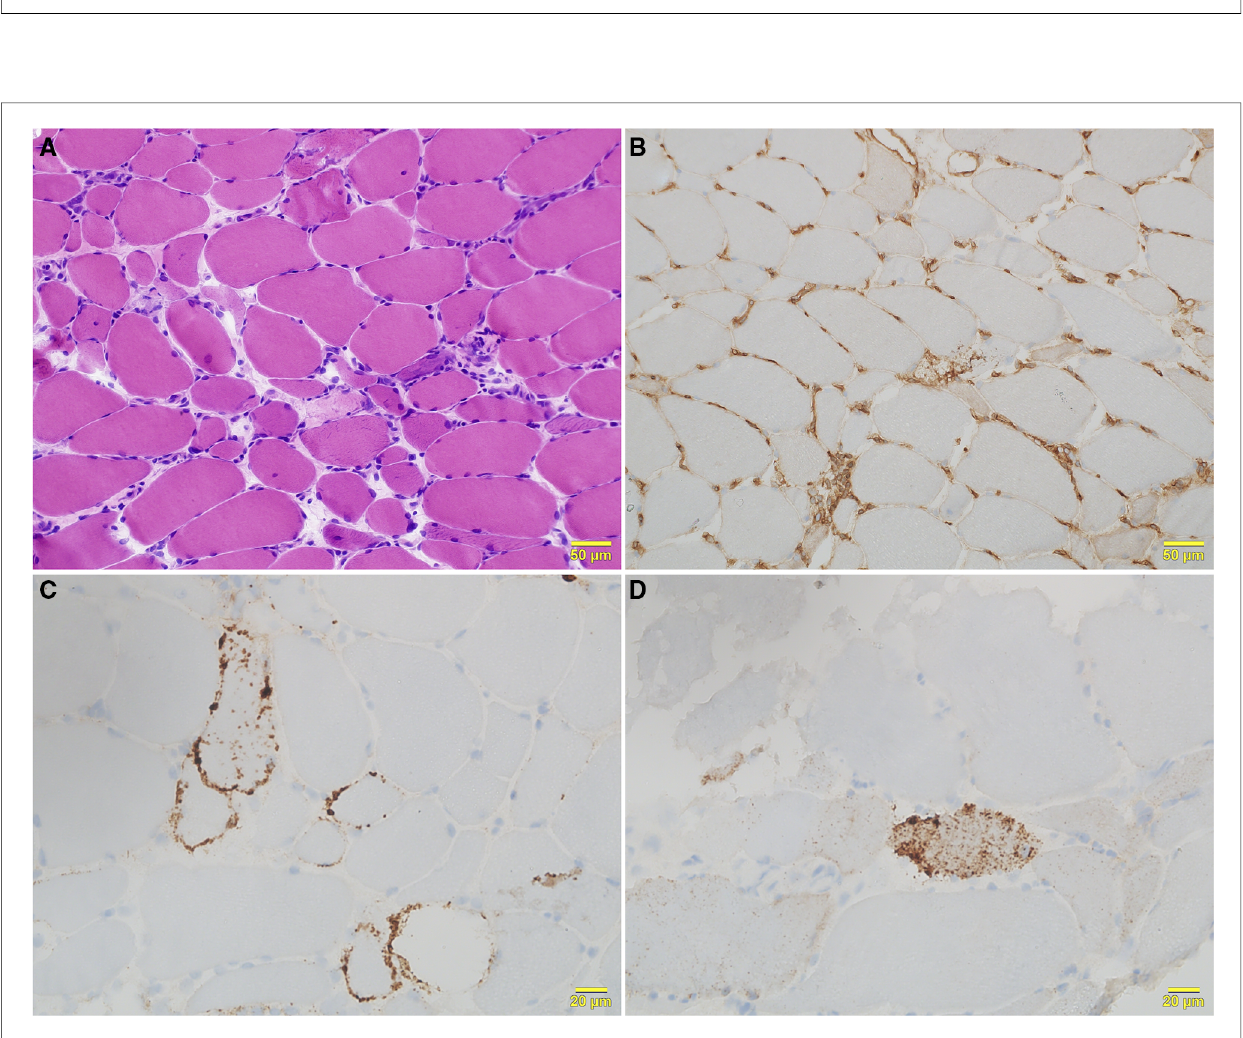
FIGURE 3 Histological features of right biceps brachii biopsy. ( A ) Hematoxylin and eosin staining shows moderate variation in fi ber size, with scattered necrotic and regenerating fi bers and mild lymphocytic in fi ltration. ( B ) Major histocompatibility complex class 1 immunohistochemical staining shows positivity on the sarcolemma of all fi bers. ( C ) Sarcolemmal deposition of membrane attack complex (C5b − 9) is seen in scattered fi bers with C5b − 9 immunohistochemical staining. ( D ) Fine granular expression of p62 is present in the sarcoplasm of scattered myo fi bers with p62 immunohistochemical